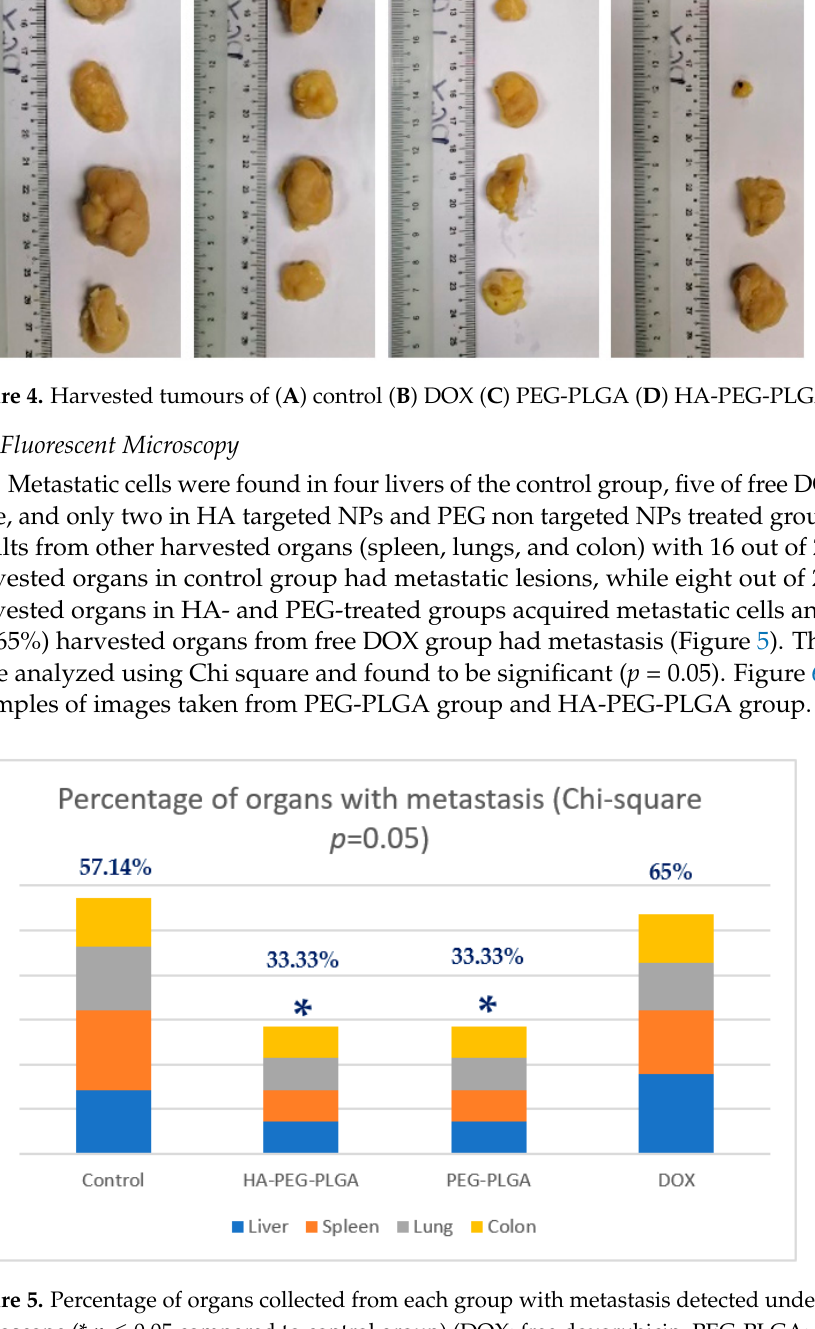
Figure 3. A : Primary tumour growth results presented in fold increase relative to day 1. * Indicates p ≤ 0.05 compared to control, B : Animal weight (DOX: free doxorubicin, PEG-PLGA: Doxorubicin